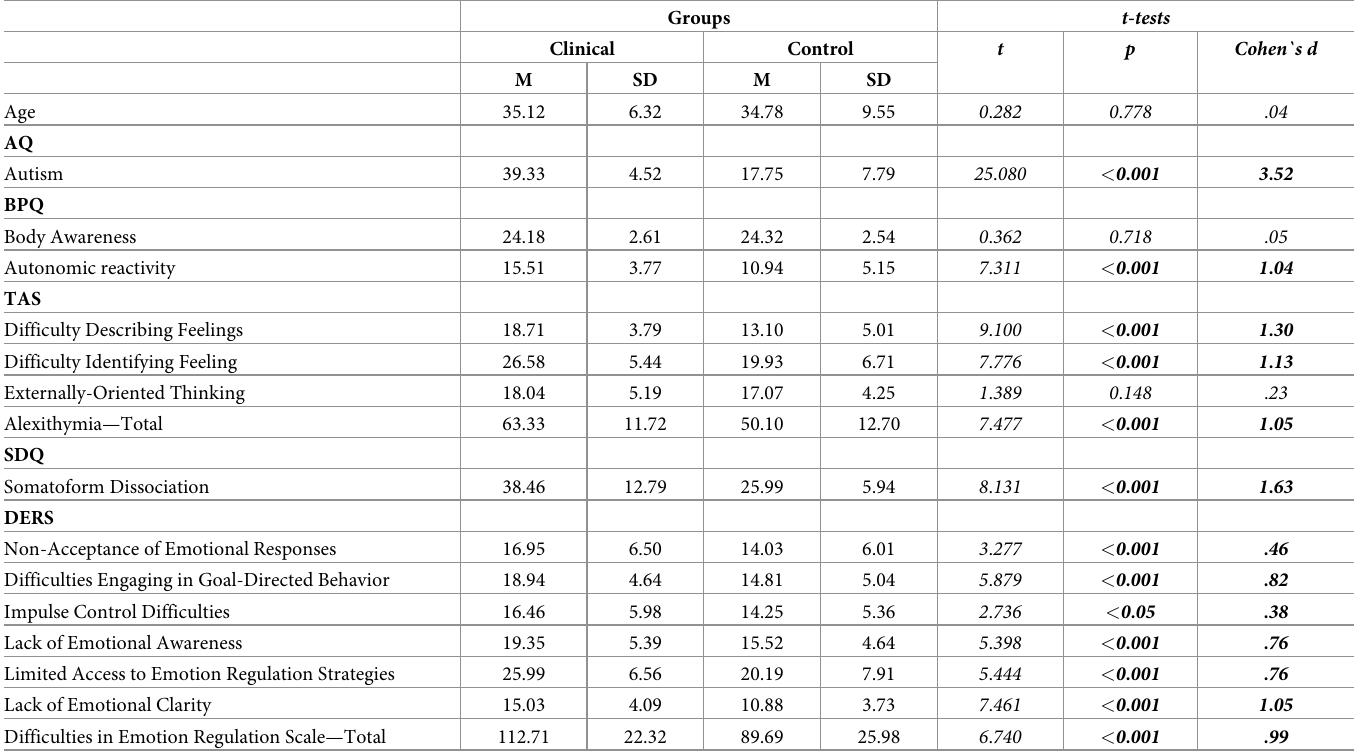
Table 1. Descriptive statistics and t-tests of the clinical (ASD) and control group.